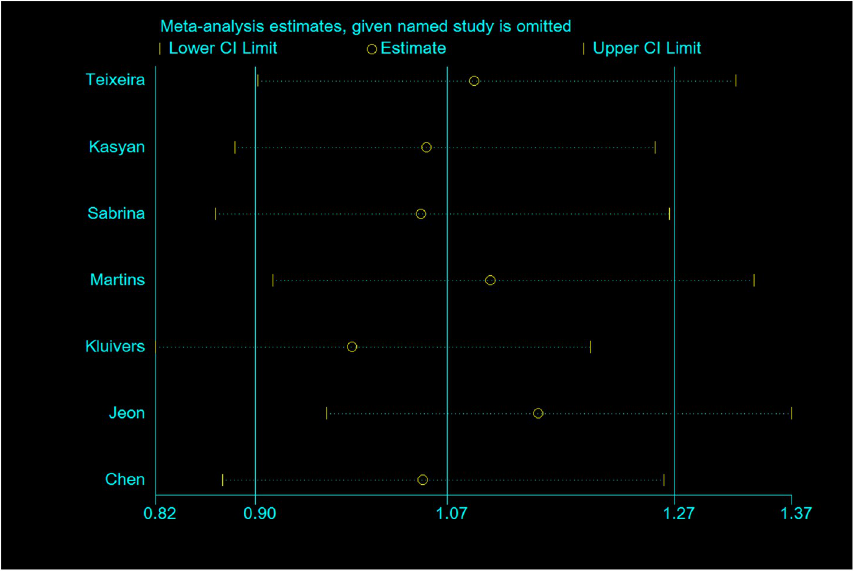
Fig 5. Sensitive analysis of COL3A1 rs1800255 polymorphism on POP risk (recessive genetic model: AA vs. GG/ GA). POP, pelvic organ prolapse; OR, odds ratio; CI, confidence